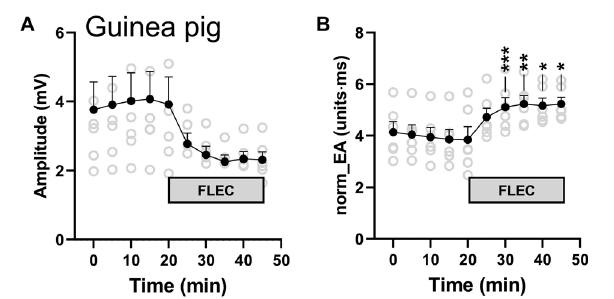
FIGURE 11 | Influence of flecainide on electrogram morphology in perfused guinea pig hearts. (A) Mean data from 6 experiments showing the effects of switching to buffer containing 4 µ mol/L flecainide on bipolar electrogram amplitude and amplitude-normalized electrogram area (norm_EA). Different from time 0; * p < 0.05, ** p < 0.01, *** p < 0.001. Data are mean ± SEM. Actual replicates are shown in gray. n = 6